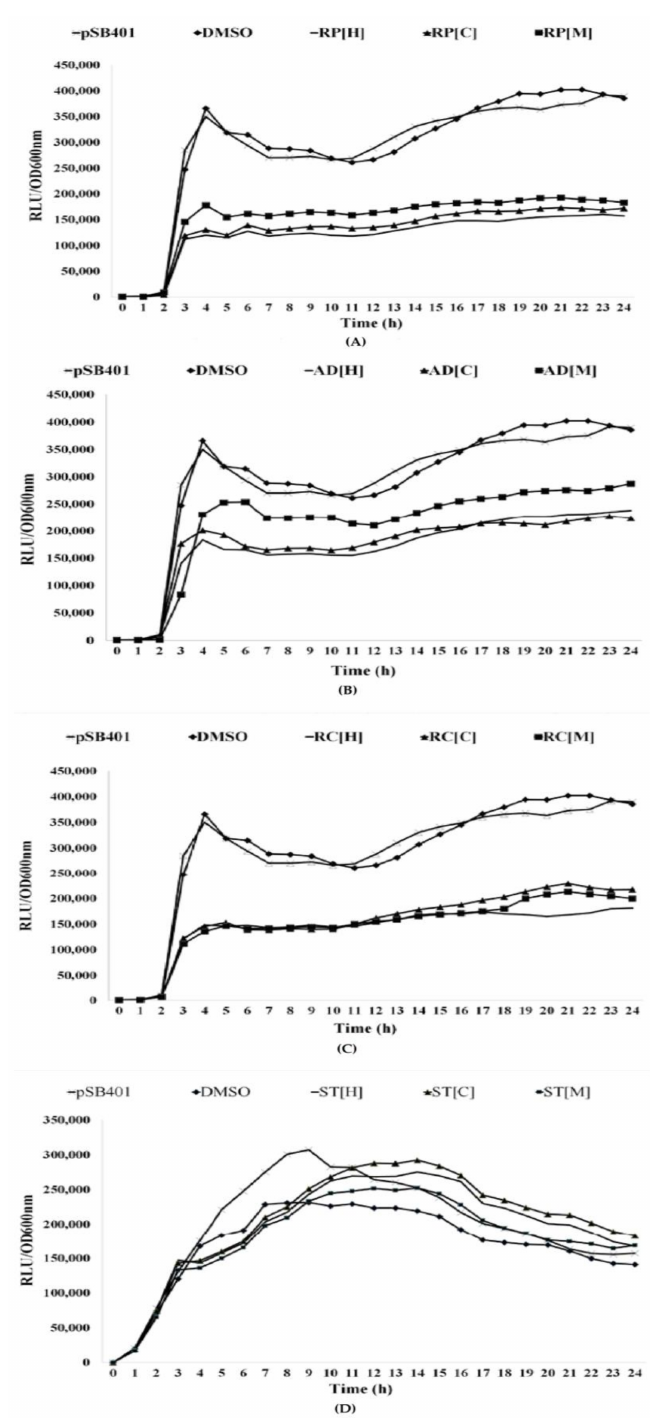
Figure 2. The inhibition of bioluminescence in E. coli pSB401 at the concentration of 1 mg/mL in hexane, chloroform and methanol. ( A ) R. pini ( B ) A. dahurica ( C ) R. cibotii ( D ) S. tenuifolia . The curve for pSB401 refers to untreated E. coli [pSB401] culture while DMSO served as negative control. Bioluminescence activities were found to decrease by half in all three of the plant samples, except for A. dahurica in methanol extracts. S. tenuifolia , on the other hand, shows negative